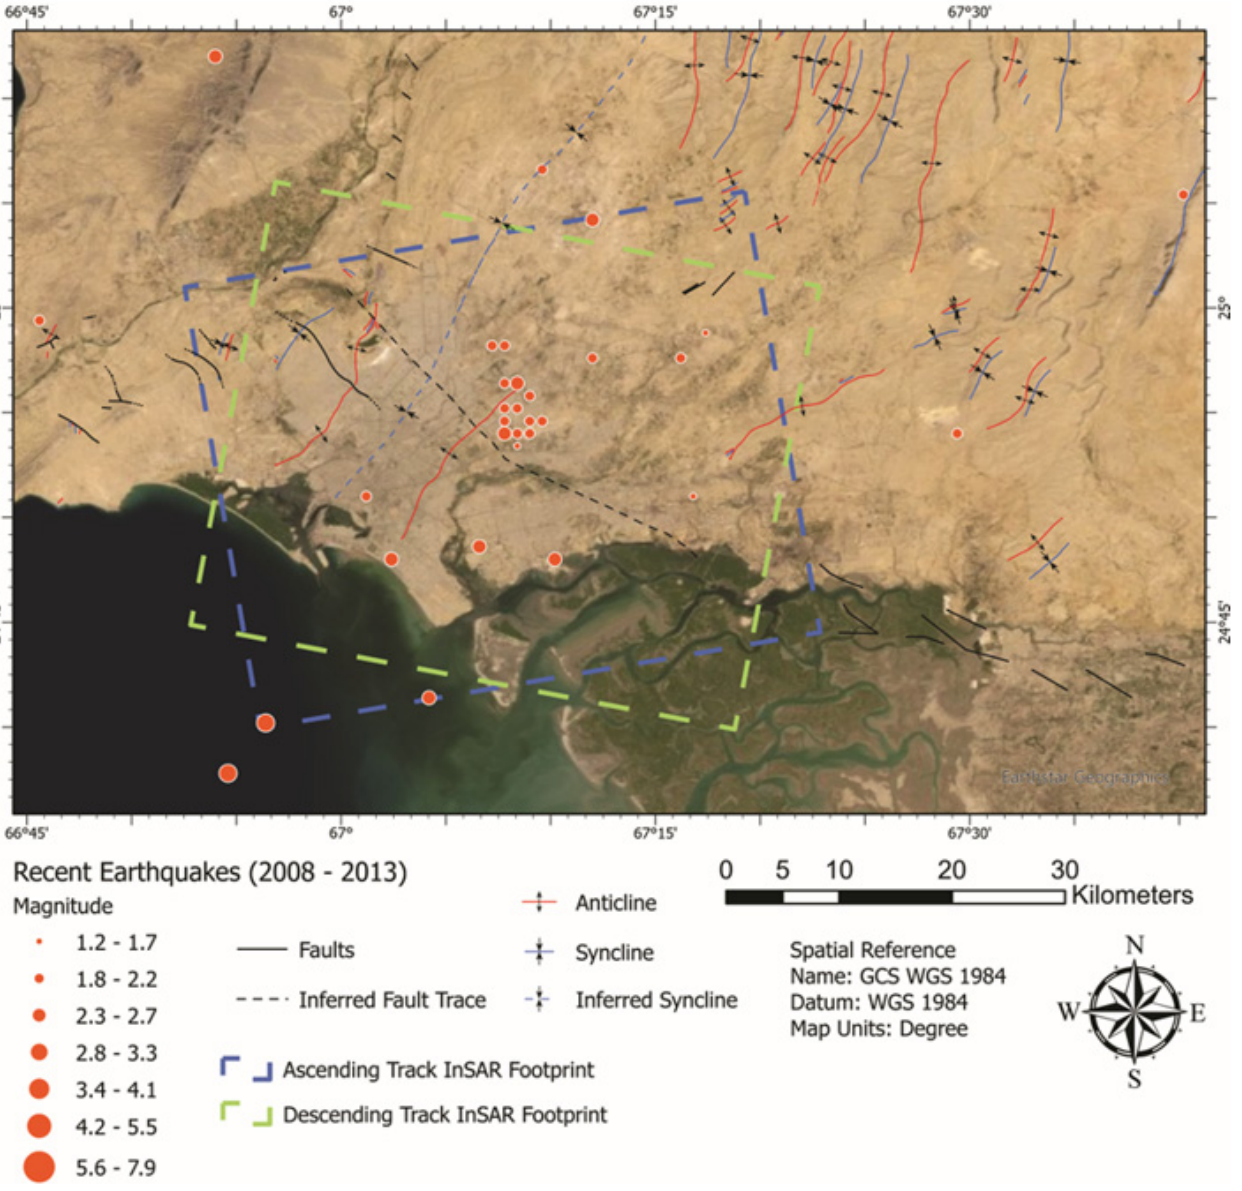
Figure 2. A map of the study area depicting key tectonic features such as anticlinesyncline pairs, faults, and recent earthquake hypocenters, along with InSAR coverage footprints. Earthquakes data source: Pakistan Meteorological Department Karachi, as presented by [14]. Faults and folds traced from Sindh geological map published by Geological Survey of